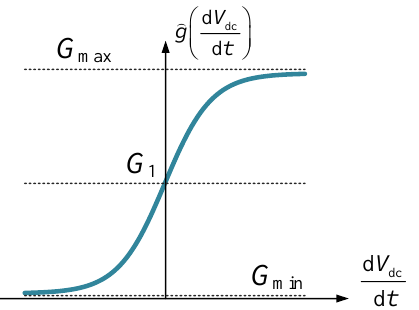
Figure 3. F lexible curve of the droop coefficient. Figure 3. Flexible curve of the droop